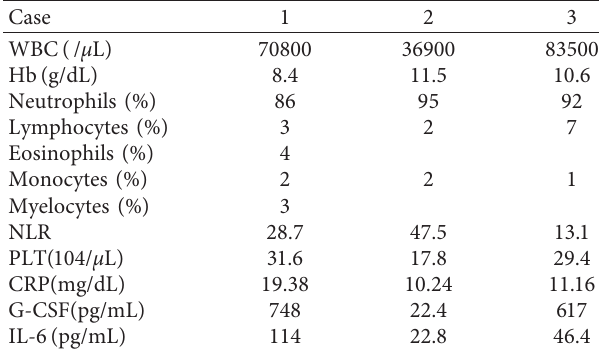
Figure 3: Clinical course of Case 3. The upper image is a chest computed tomography image of the mediastinal condition, and new lesions appeared in the mediastinal lymph nodes and pleura. In the lower image, the target lesion became partial response after lenvatinib treatment; then, it became progressive disease after anaplastic transformation. The graph below the image shows the transition of thyroglobulin, the timing of lenvatinib treatment, and the dose. The red dotted circle indicates the lesion. The red arrow indicates the time of anaplastic transformation. Table 1: Blood test findings in the three